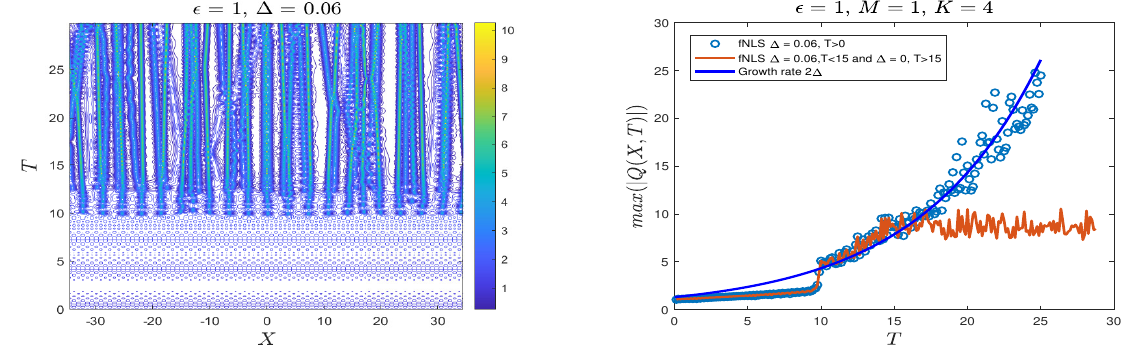
Figure 21. Case 4: The initial condition is (14). Contour plot and the maximum of | Q ( X , T ) | with growth rate 2 ∆ when M = 1.0, (cid:101) = 1.0, K = 4.0 for ∆ = 0.06. Forcing is turned off when T >